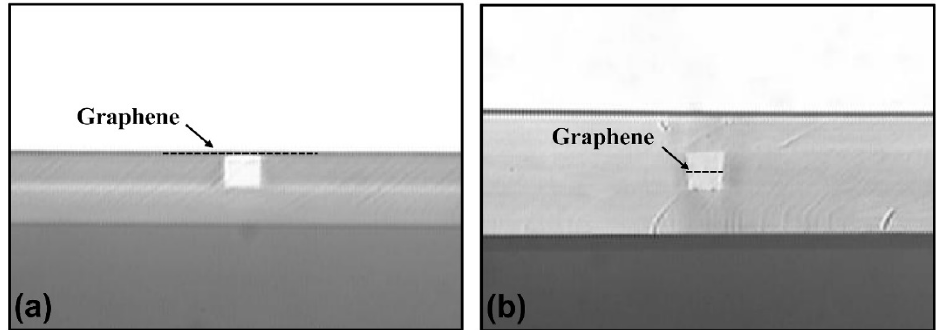
Figure 5. Cross sections of two fabricated polarizers, which incorporate, respectively, the graphene film was placed ( a )on the surface of core layer and ( b ) buried in the center of core layer. To characterize the performance of the fabricated polarizers based on the gra- phene-buried polymer waveguides, we used the polarization optics to control and mon- itor the polarization states of the input light and the output light. The input signal light from a semiconductor tunable laser (TSL-510, Santec, Aichi, Japan) is coupled directly into the input port of the polarizer through a lensed single-mode fiber (SMF) with a mode-field diameter of 2.5 µm. The output light beam from the polarizer can be collected with a lens, which images the output near-field patterns, and observed by an infrared charge-coupled device (CCD) camera. The images can be displayed on a video monitor during the testing process. After finding the output pattern, the output light was coupled into an optical power meter through a SMF to measure the output optical power from the polarizer and calculate the loss induced by graphene film and the insertion loss of the polarizer. By comparing the losses measured for the graphene-buried waveguide and the reference waveguide without graphene film, the losses induced only by the graphene films can be obtained. The variation of graphene-induced losses of the polarizers with the operating wavelength is indicated in Figure 6. Within a broad bandwidth over 110 nm in the telecommunication wavelengths, the polarizers present low loss and large extinction ratio (the difference between the graphene-induced losses for fundamental TM and TE modes), which are more than 45.1 dB and insensitive to the wavelength.